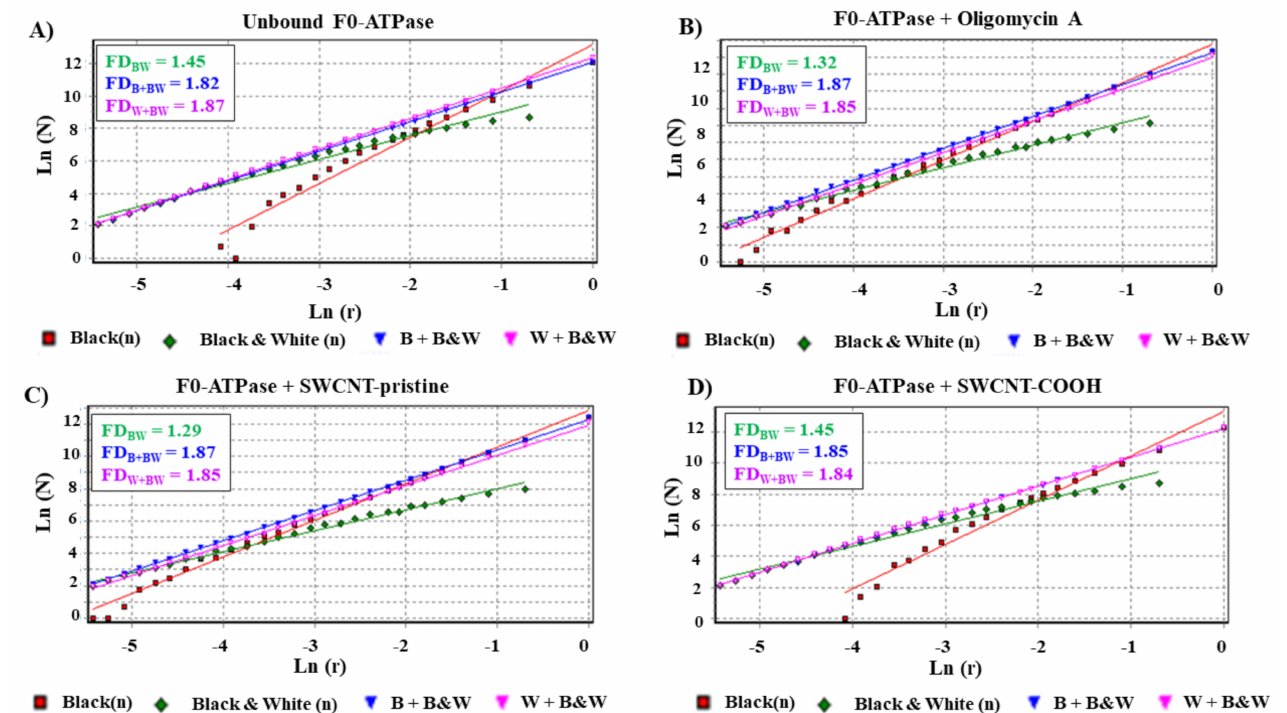
Figure 5. Fractal spectrum based on the box-counting method performed to obtain the slopes of the linear regression yields from binary black/white LPRS maps image-processing. These slopes represent the fractal dimensions (FD: D BW , D B+BW , and D W+BW ) for the best docking complexes, namely: ( A ) unbound F0-ATPase, ( B ) oligomycin A/F0-ATPase complex, ( C ) SWCNT-pristine/F0-ATPase complex, and ( D ) SWCNT-COOH/ F0-ATPase